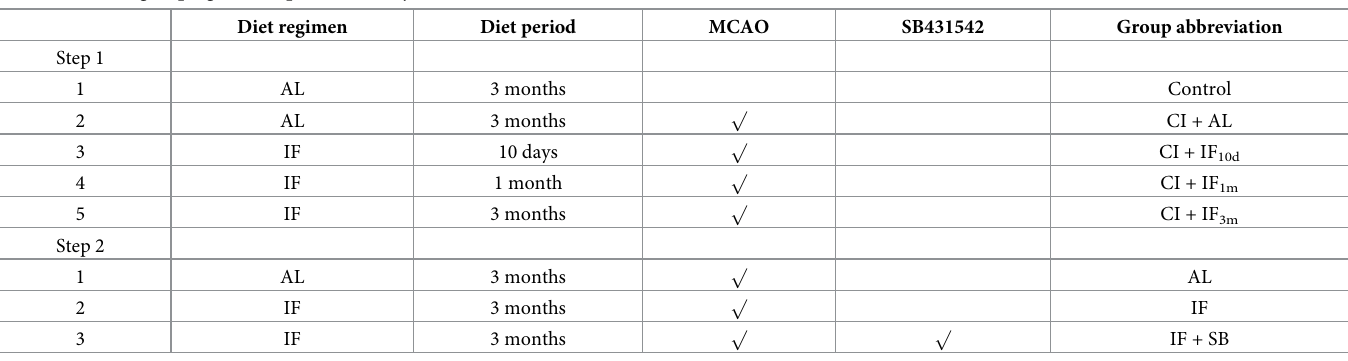
Table 1. Animal grouping for 2 steps in this